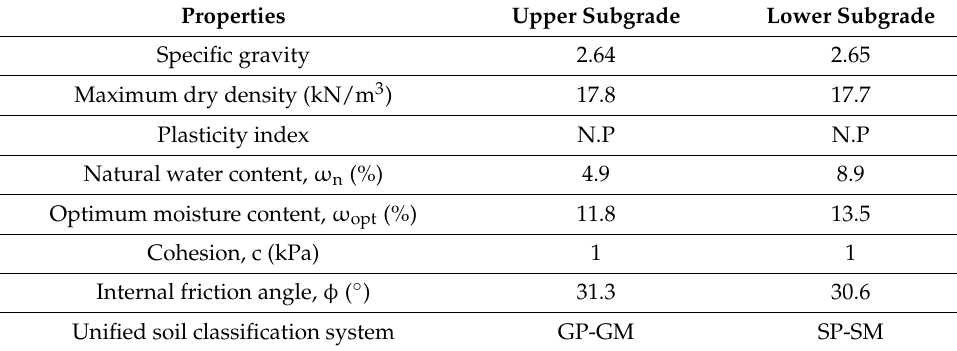
Table 2. Test result of backfill